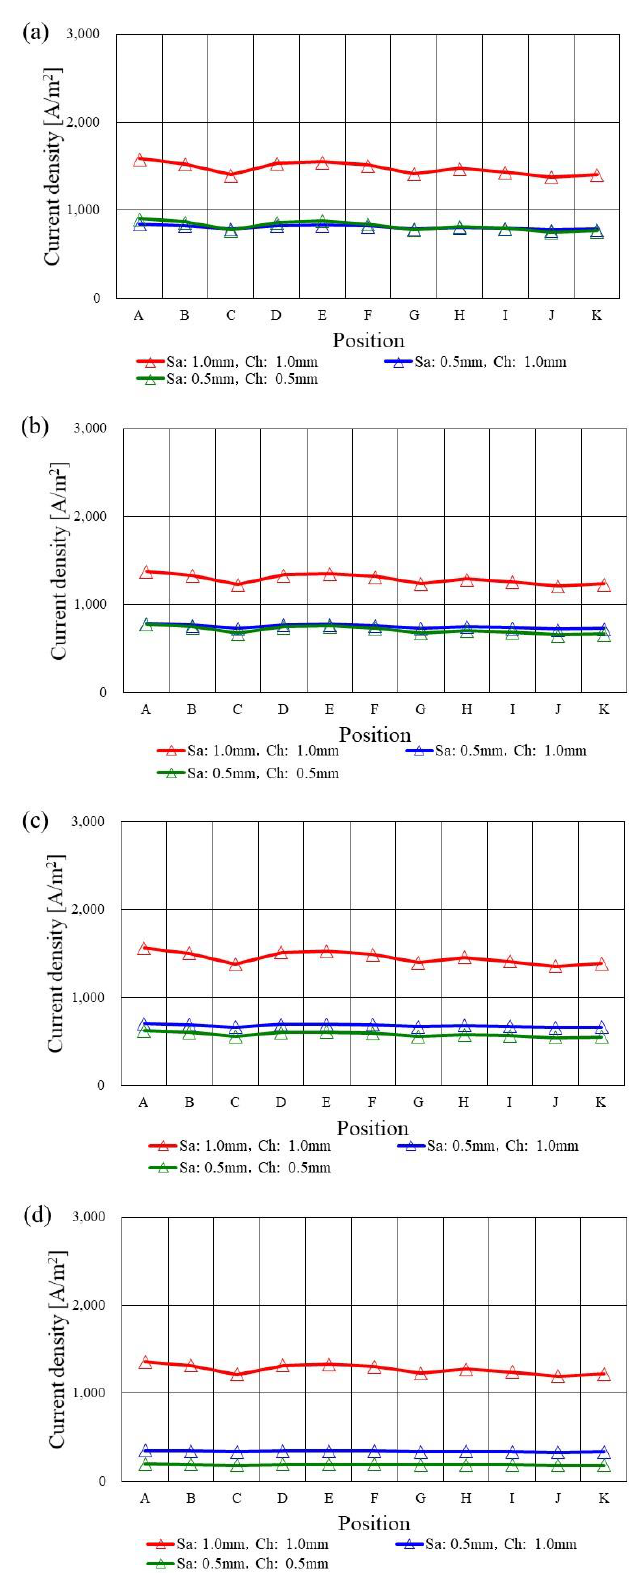
Figure 12. Current density along with the gas channel on the interface between PEM and catalyst layer at the cathode among various s.t. at T ini = 363 K. ( a ) A80%RH/C80%RH, ( b ) A80%RH/C40%RH,